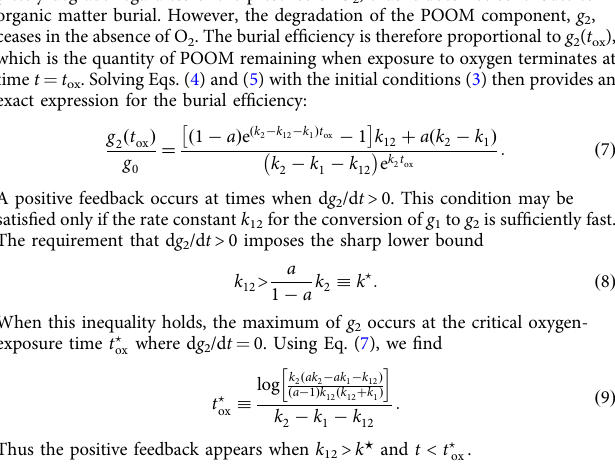
(Supplementary Table 1) of SAR202 cluster bacterium Io17-Chloro-G4. Ribosomal proteins are from 298 taxa (Supplementary Table 2), including 203 taxa directly collected from the NCBI database and 95 taxa provided in 50 . To reconstruct the gene tree of BVMOs, we used 330 protein sequences homologous to the BVMO